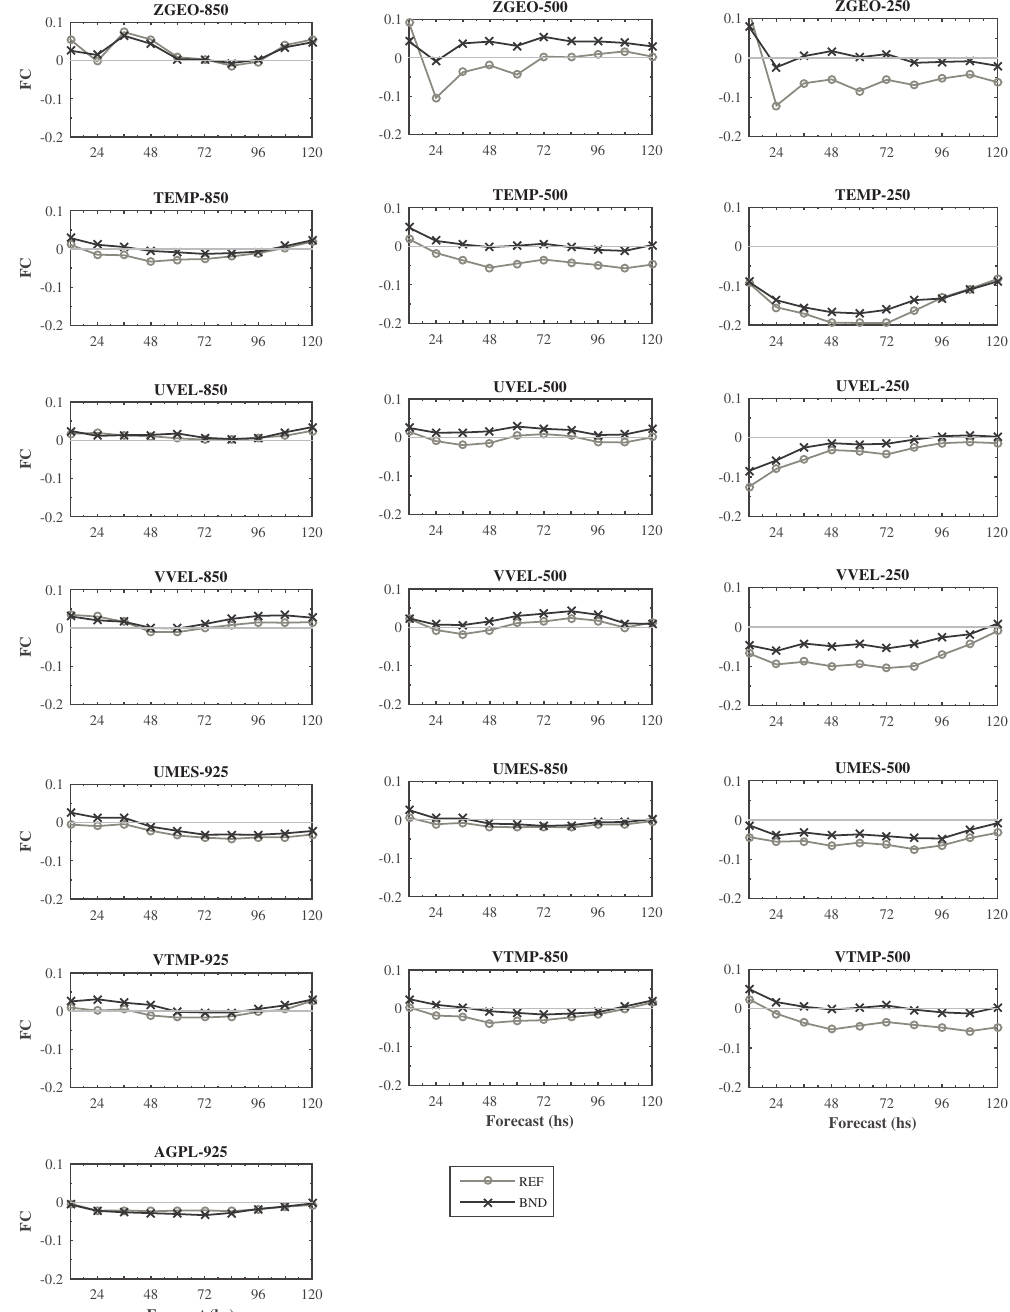
Figure 9. Fractional change of the RMSE values for all variables evaluated and the 120 h of model integration over the South America